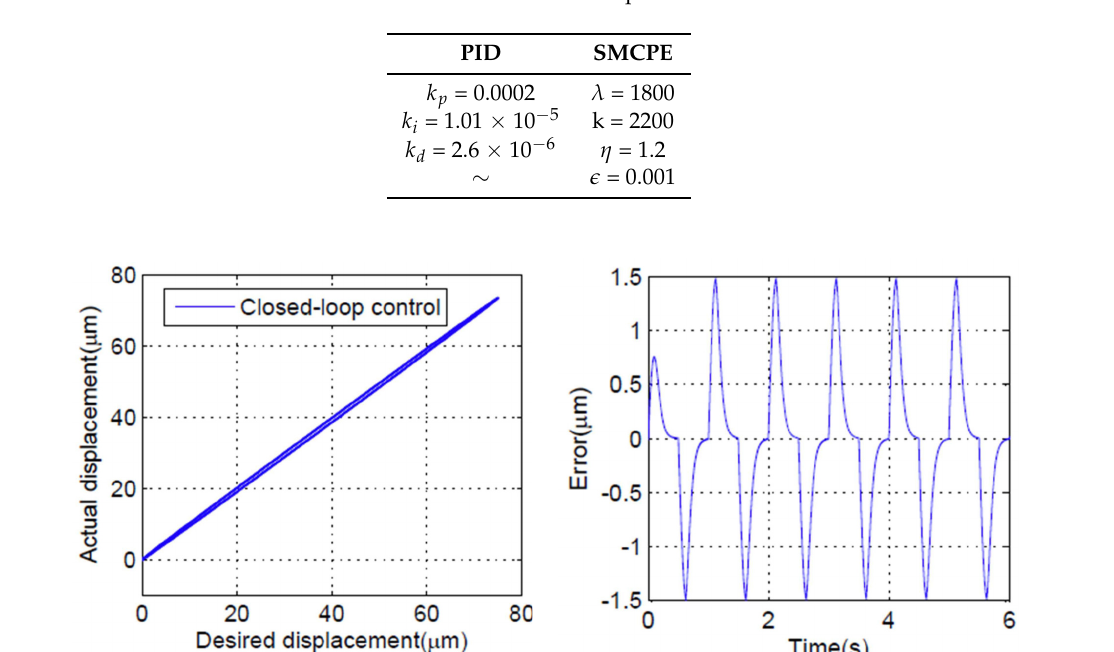
Table 2. Value of the control parameters.